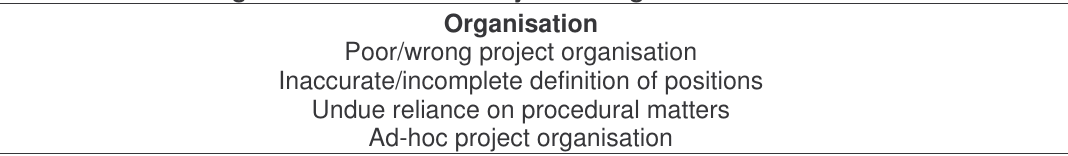
Figure 3: Problems of Project Management in